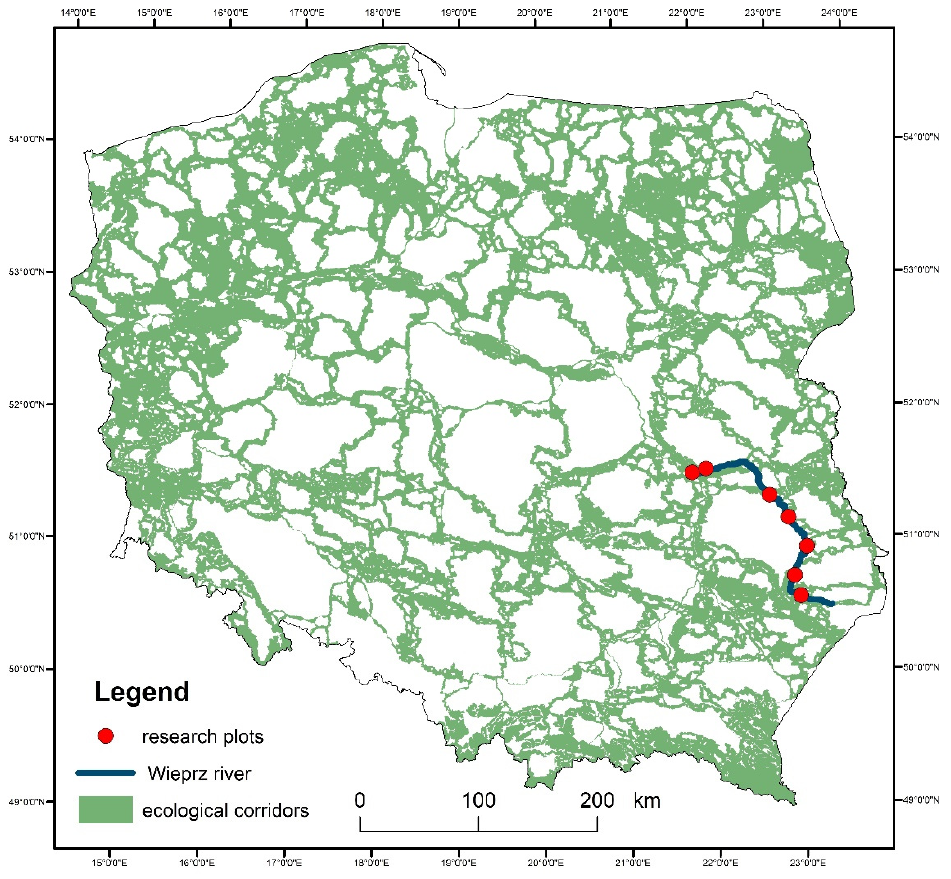
Figure 1. Network of ecological corridors in Poland based on the study by the Mammal Research Institute of the Polish Academy of Sciences [7]. The ecological river corridors in Poland are marked in green; the blue line marks the course of the ecological corridor in the Wieprz River valley.